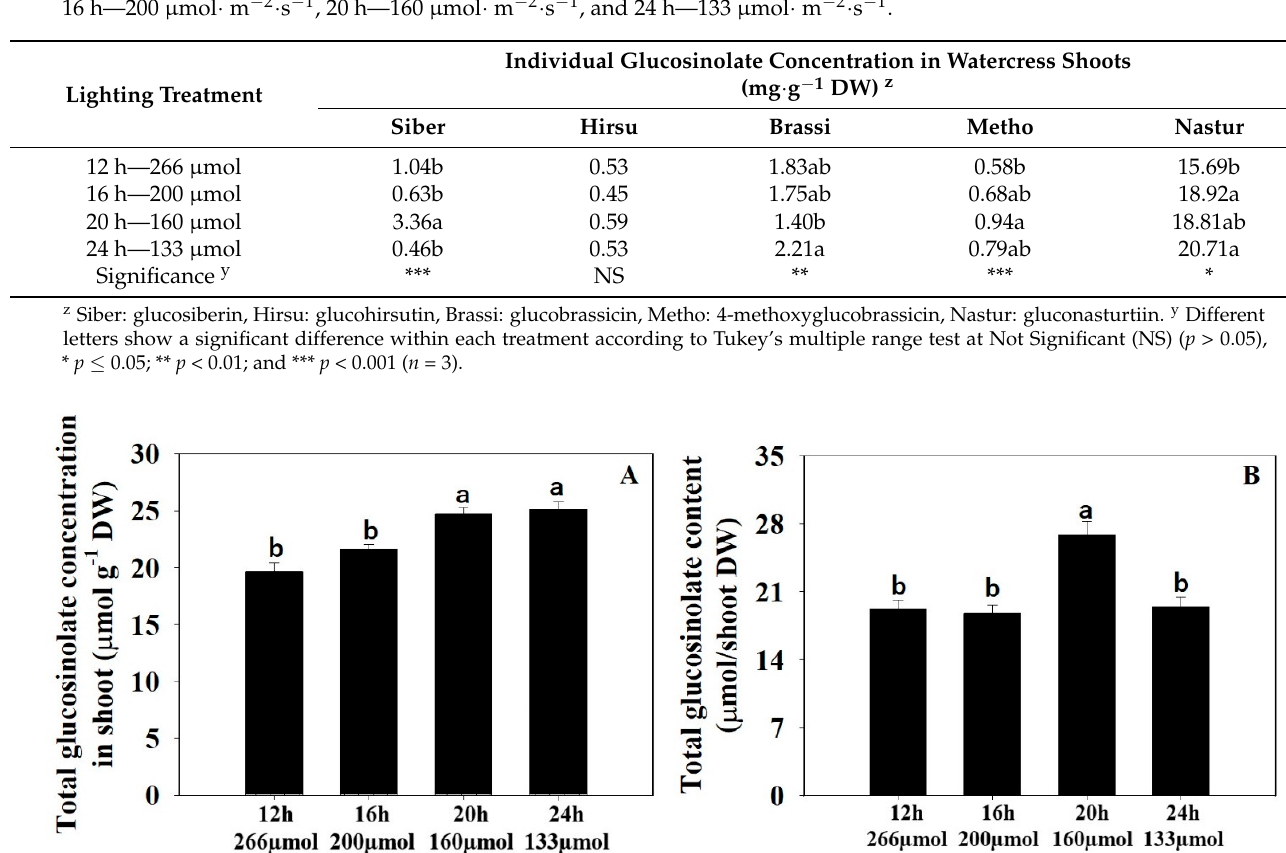
Table 2. The individual glucosinolate concentration of watercress under different lighting treatments of 12 h—266 µ mol · m − 2 · s − 1 ,